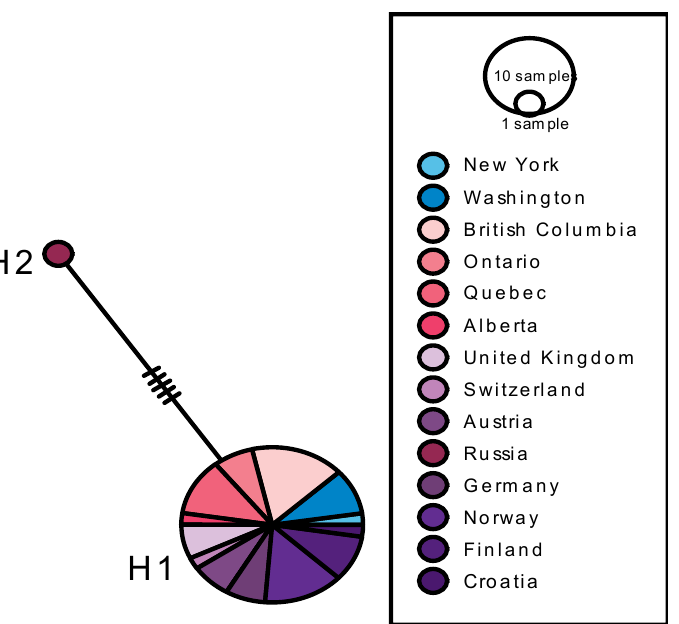
Figure 5. TCS (Templeton-Crandall-Sing) network depicting relationships between COI haplotypes of Depressaria radiella . Partial COI sequences for all individuals in this analysis were retrieved from the BOLD database. The size of each circle represents number of individuals belonging to each haplotype (H1–2). The number of hash marks on branches between haplotypes represent the number of mutational steps.